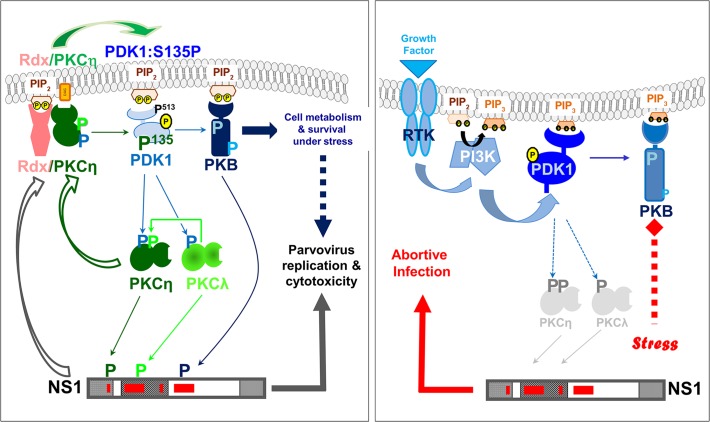
Interdependence of PV propagation and activation of the PDK/PKC/PKB signaling cascade.Schematic representation of parvoviral interaction with the PDK1/PKC/PKB signaling cascade in permissive host and human cancer cells (left panel) versus non-permissive normal human cells (right panel). In permissive cells (e.g. tumor cells) PDK1-S135 phosphorylation stimulates parvovirus propagation and prolongs survival independently of growth factor signaling. In non-permissive normal human cells, due the failure of PVs to induce PDK1 stimulation, NS1 remains inactive.